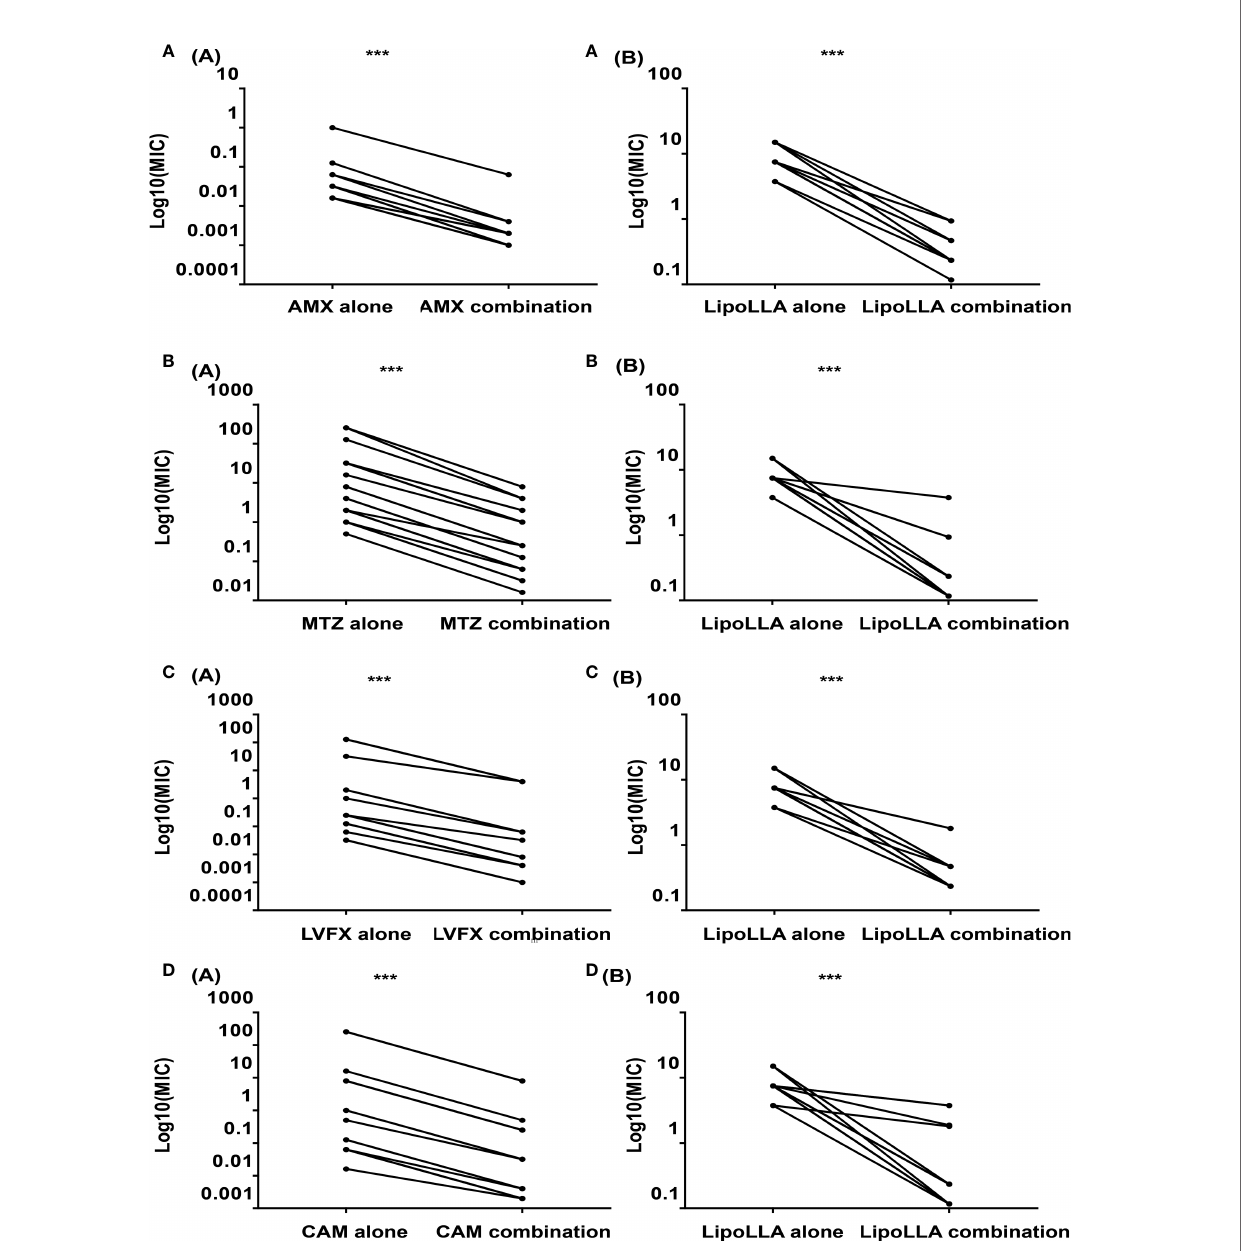
FIGURE 1 | Synergistic effects of LipoLLA with antibiotics against H. pylori. The MICs of LipoLLA and four antibiotics against H. pylori were signi fi cantly decreased after the combination of LipoLLA with AMX, MTZ, LVFX and CAM respectively. (A) After AMX was used in combination with LipoLLA, MICs of AMX(A(A)) and LipoLLA(A(B)) were signi fi cantly reduced compared with the two alone. (B) When LipoLLA was combined with MTZ, the MICs of MTZ(B(A)) and LipoLLA(B(B)) decreased signi fi cantly with alone. (C) When LipoLLA was combined with LVFX, MICs of LVFX(C(A)) and LipoLLA(C(B)) were signi fi cantly reduced compared with the two alone. (D) After CAM combined with LipoLLA, the MICs of CAM(D(A)) and LipoLLA(D(B)) decreased signi fi cantly with alone. AMX (alone), the MICs of amoxicillin against 30 H. pylori strains when used alone; AMX (combination), the MICs of amoxicillin against 30 H. pylori strains when combined with LipoLLA; LipoLLA (alone), the MICs of LipoLLA against 30 H. pylori strains when used alone; LipoLLA (combination), the MICs of LipoLLA against 30 H. pylori strains when combined with amoxicillin.